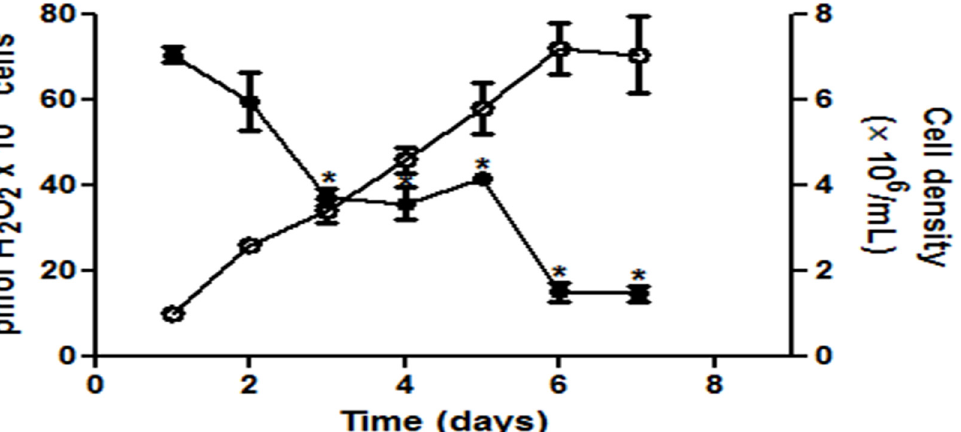
Fig 1. Hydrogen peroxide production during L . amazonensis proliferation days. The graph shows the hydrogen peroxide production (closed circles) and the number of cells present in the culture medium on each of the days (open circles). The values represent the mean ± standard error of at least three independent experiments. * Statistically significant when compared to day 1 (P < 0.05).